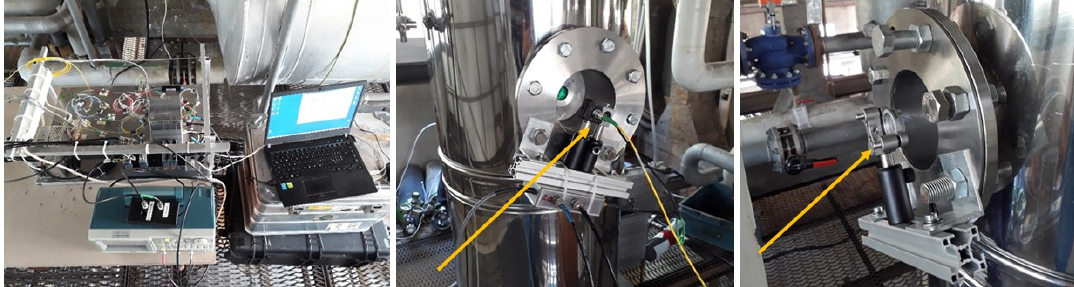
Figure 4. ( left ): main plate of the mechanics, together with the waveform generator and the laptop; ( center ): launching optics, driven by the yellow optic fiber, and detector; ( right ): steering mirror, which reflects the laser beam onto the